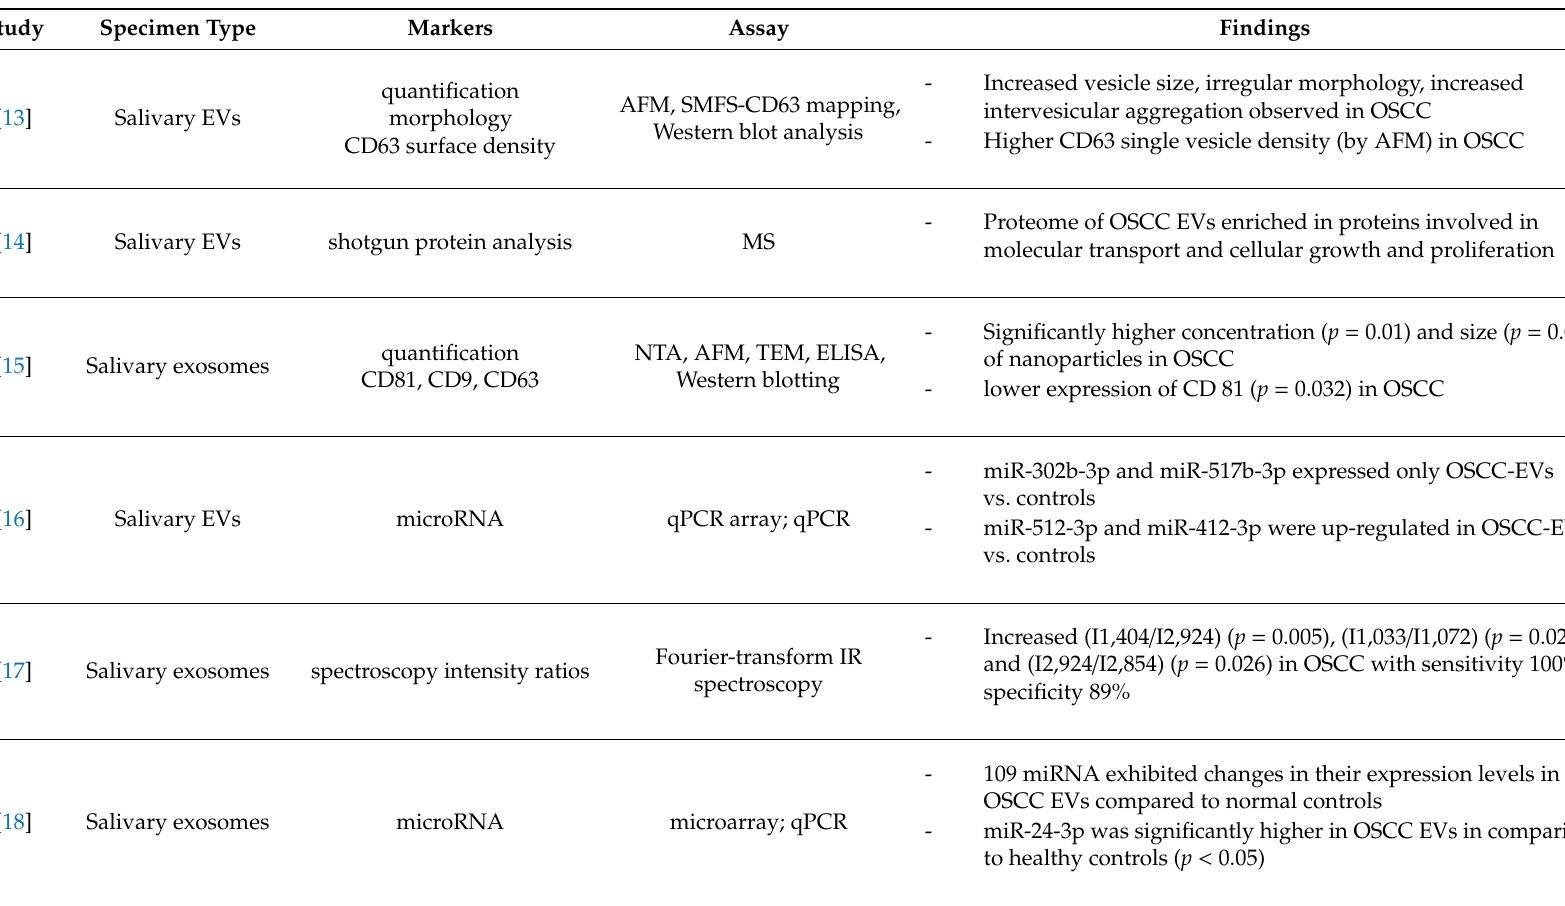
Table 1. Findings from eligible studies assessing extracellular vesicles (EVs) in oral squamous cell carcinoma (OSCC) and oral potentially malignant disorders (OPMD) clinical cohort